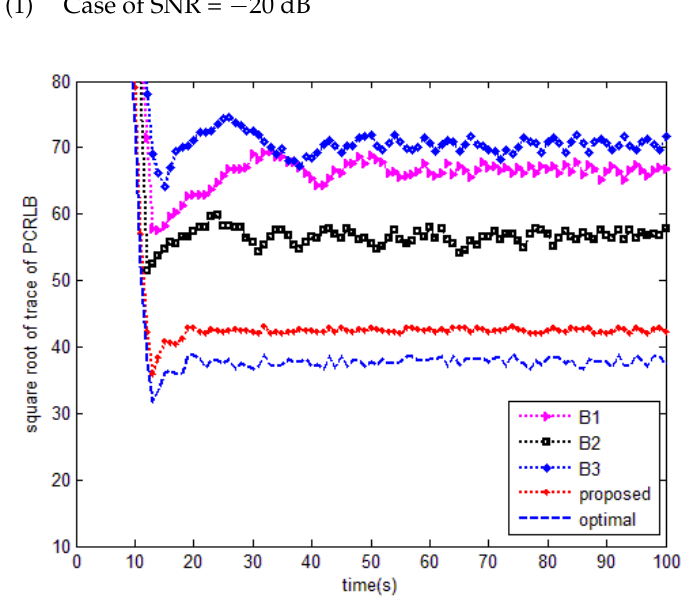
Figure 7. Comparison of the trace of PCRLB.